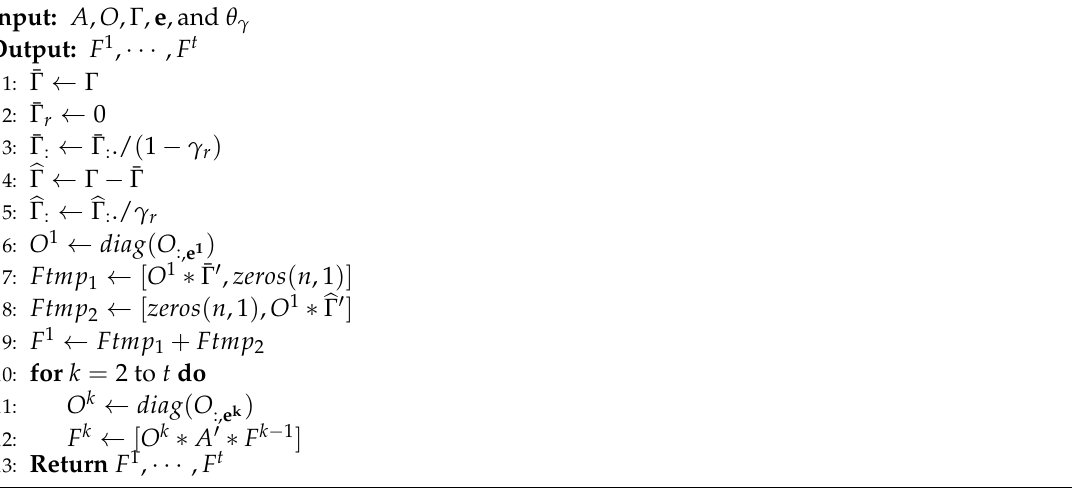
Algorithm 2 This computes the coefficients of the forward (filtering) probability sensitivity